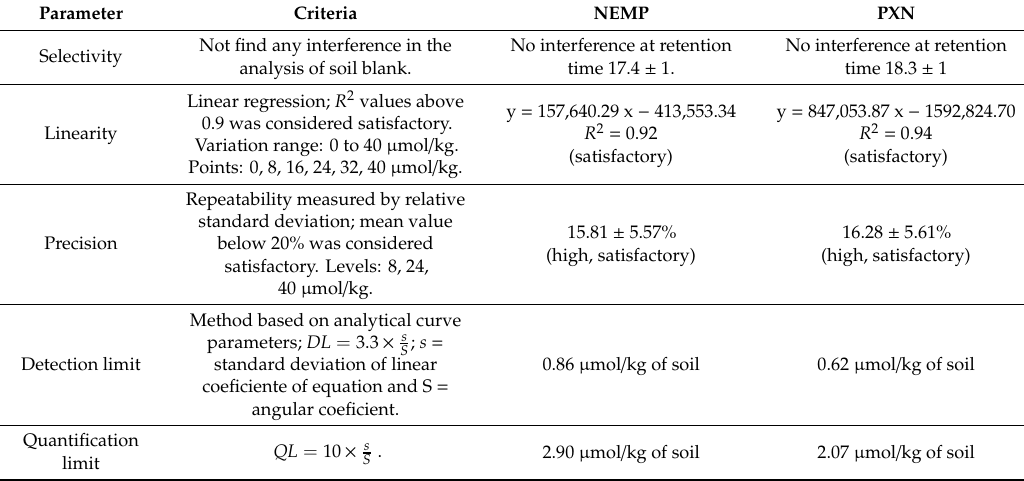
Table 4. Evaluation of the quantitative methodology results.